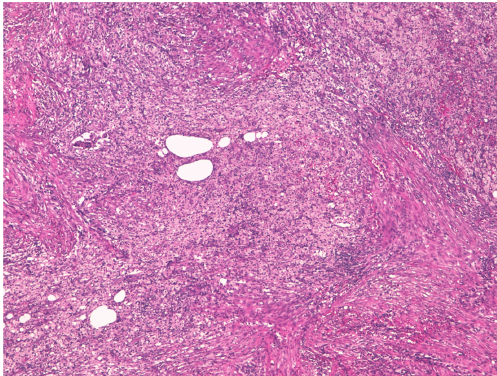
Figure 3: The retroperitoneal mass consisted of chronic suppura- tive granolomatous inflammation, H&E